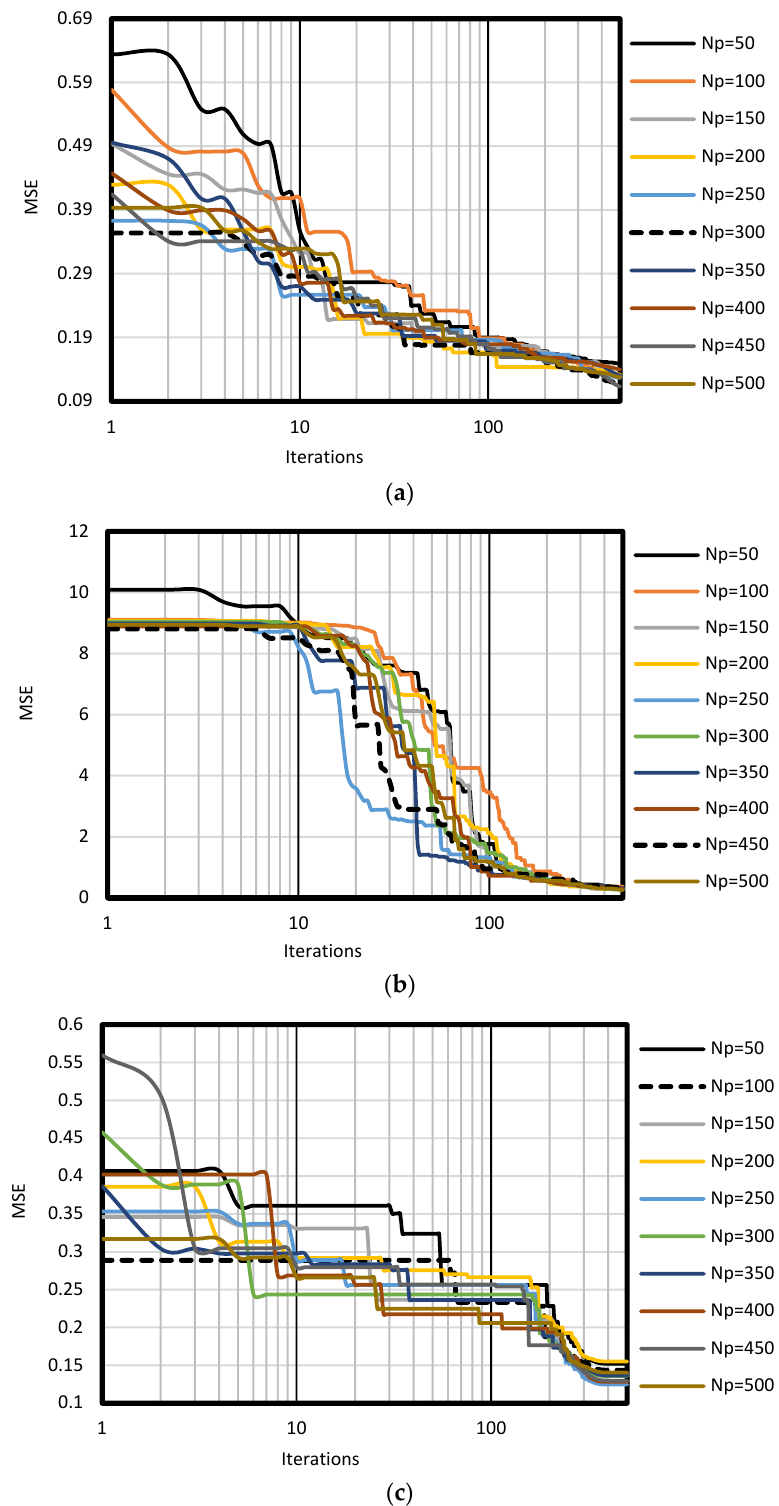
Figure 3. Model iterations versus the variation of MSE; ( a ) MVO-MLP, ( b ) SOSA-MLP, ( c ) VSA-MLP.